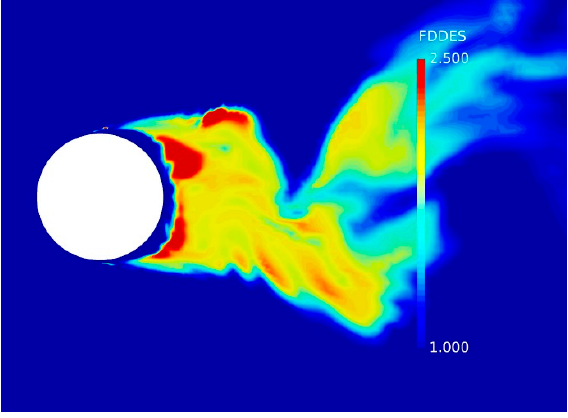
Figure 11. Example of instantaneous blending function F DDES around circular cylinder.